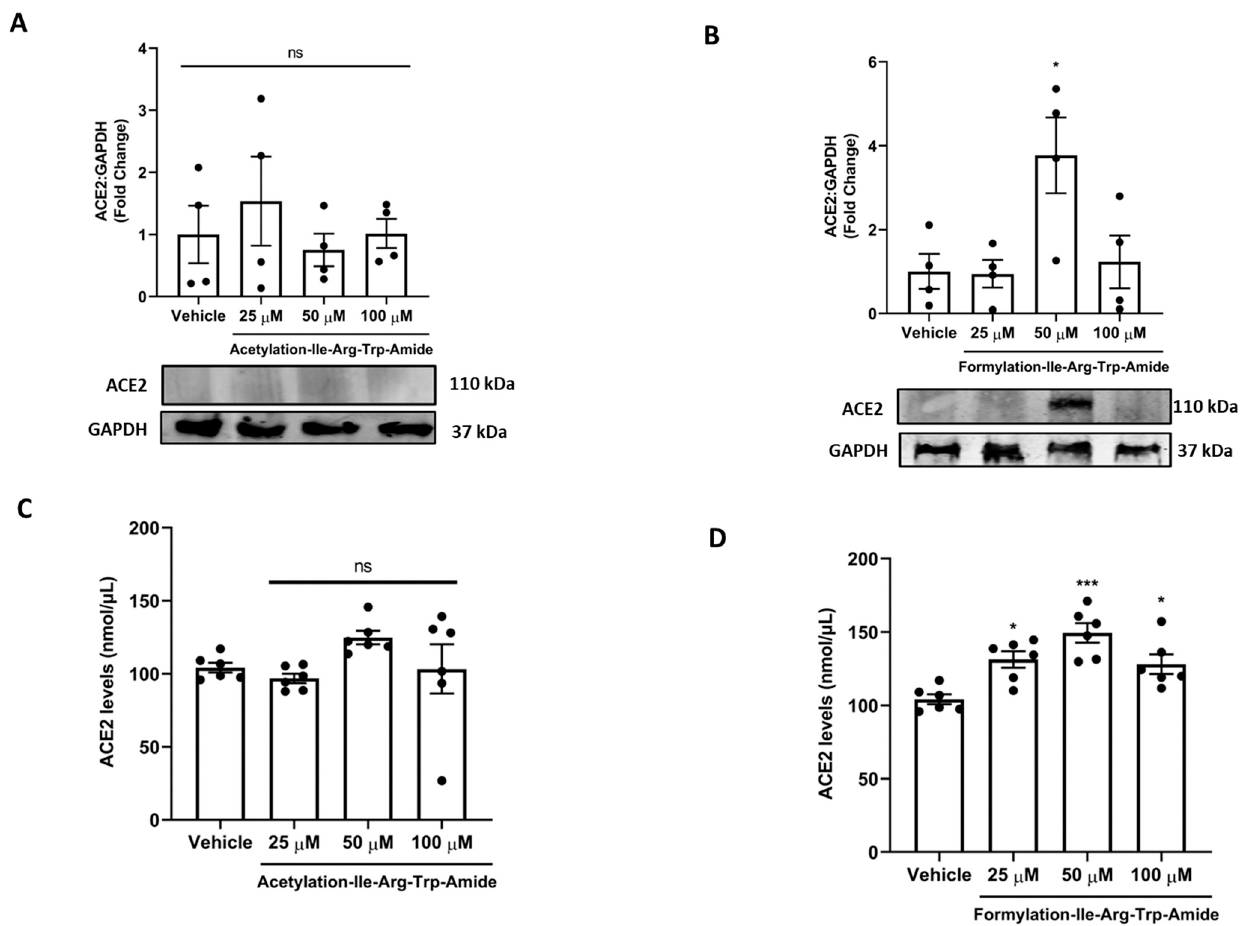
Figure 4. Impact of peptides A9 and A14 on ACE2 levels in cells. ( A , B ) Immunoblots showing the changes in ACE2 levels of HEK293T cells after treatment with A9 and A14 at the different tested concentrations and ( C , D ) impact of A9 and A14 on cellular levels of ACE2 using an activity assay Kit (ab273297, Abcam, Toronto, ON). HEK293T cells were grown in DMEM complete media containing 10% FBS with antibiotics. The cells were treated with vehicle (nuclease free water) or A9 or A14 at different concentrations (25, 50, and 100 µM) for 24 h. Thereafter, protein was extracted using RIPA buffer and was stored at − 20 °C till further analysis. For immunoblotting, the results are expressed as change in ACE2 fold change with respect vehicle control (nuclease free water). For ACE2 activity assay, the results were expressed as nmol of ACE2 per µL of cell extract. Data expressed as mean ± SEM of n = 4–6. p values were determined by Analysis by one-way ANOVA followed by Bonferroni’s post hoc test for vehicle. * p < 0.05 and *** p < 0.001 indicate versus vehicle. The error bar indicates S.D. of the mean value. µM: micromolar, ns: nonsignificant.